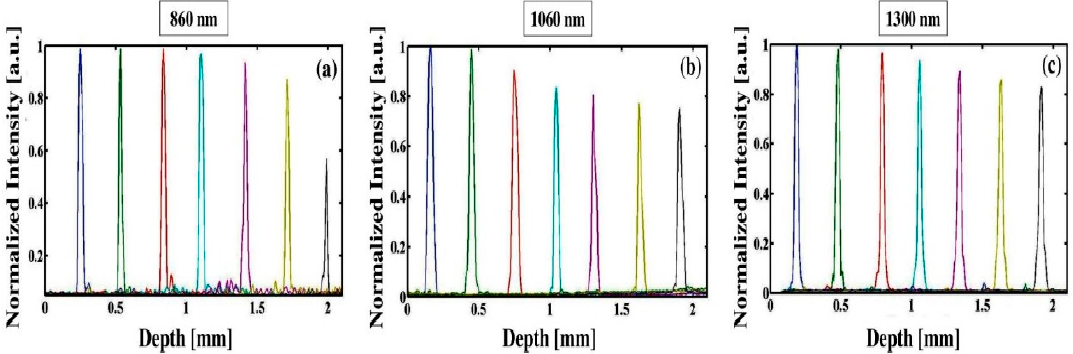
Figure 1. The depth dependent sensitivity fall-off comparison of the three OCT systems. ( a – c ) The sensitivity fall-off representations of 860 nm, 1060 nm, 1300 nm OCT systems, respectively.